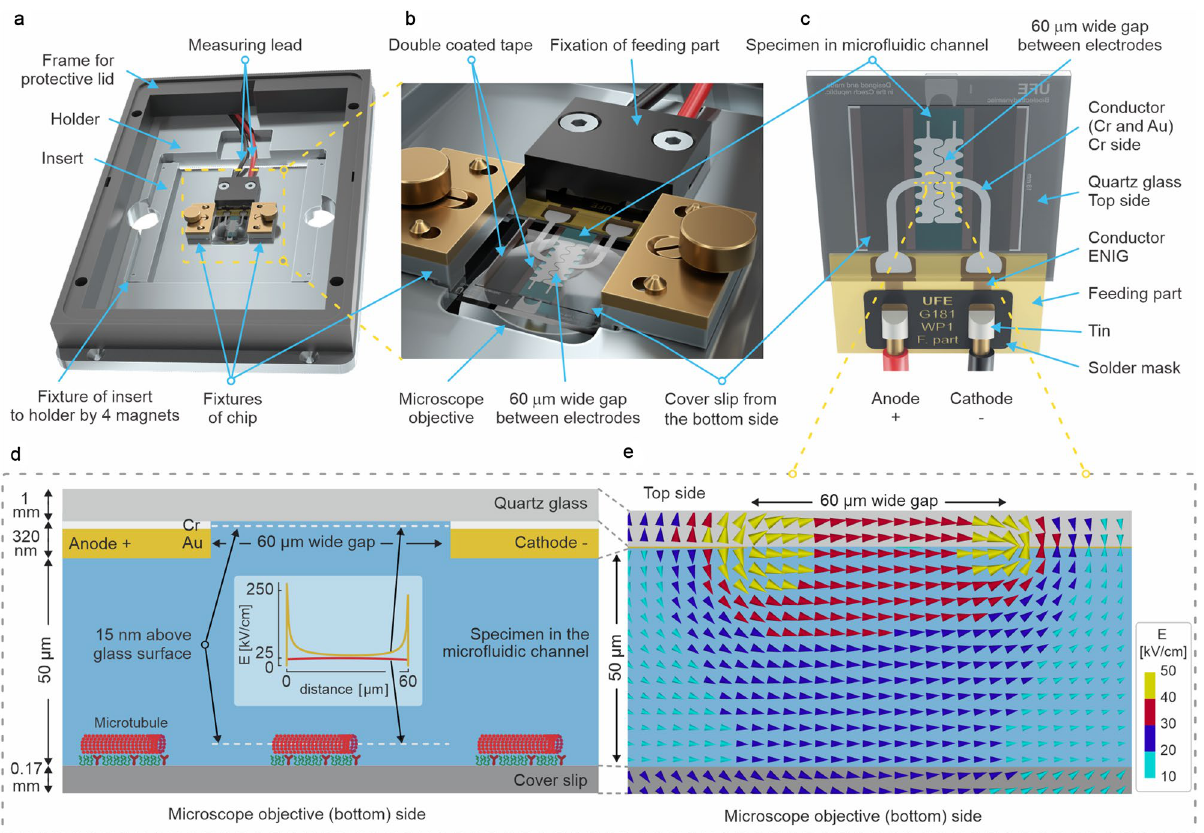
Figure 1. Chip platform design and electric field simulations. (a) A model of the chip platform with a frame for the protective lid. (b) Detail of the fixed chip with a microfluidic channel in electrical contact with the fixed electrical feeder on the insert under supervision of the microscope objective from the bottom. (c) Detail of the chip with a microfluidic channel and electric feeder. (d) A description of the perpendicular cross-section through the microfluidic channel in the area of the 60 µ m gap between two electrodes (anode and cathode). The graph in the inset depicts a comparison of electric field strength calculated on the 60 µ m long white dashed lines localized 15 nm from both the top and bottom of the microfluidic channel. (e) A calculated time snapshot of the 2D electric field strength distribution (arrows indicate electric field vector) in the cross-section described in (c) excited by a 300 V